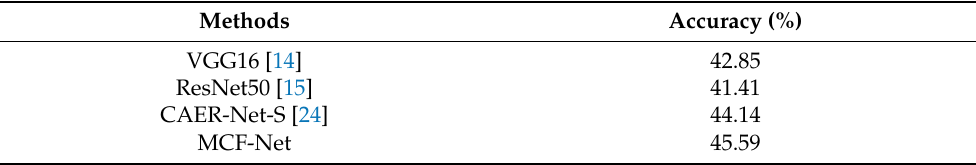
Table 3. Comparison results using NCAER-S